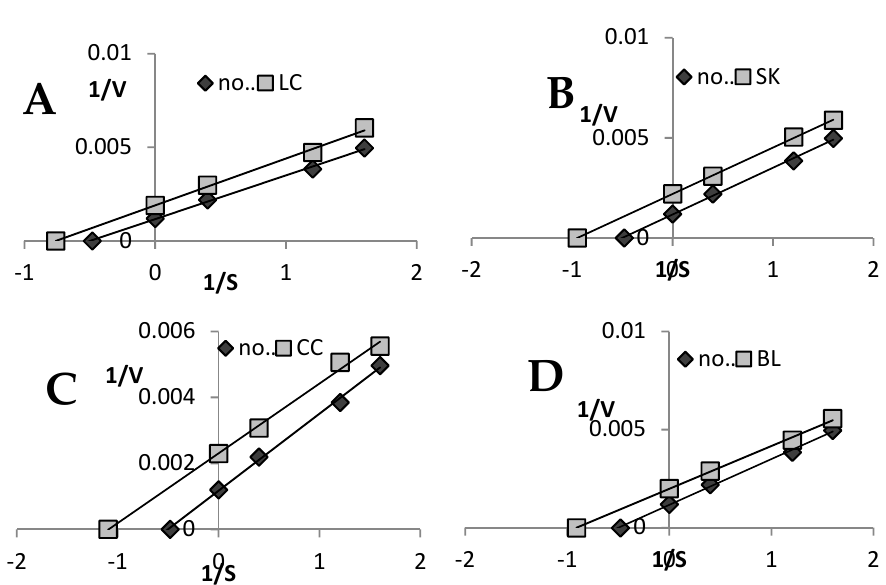
Figure 5. Mode of lipoxygenase inhibition by extracts from red chard ( A ), white beetroot ( B ), red beetroot leaves ( C ), and white chard ( D ). LC—red chard; SK—white beetroot; CC—red beetroot leaves; BL—white chard.